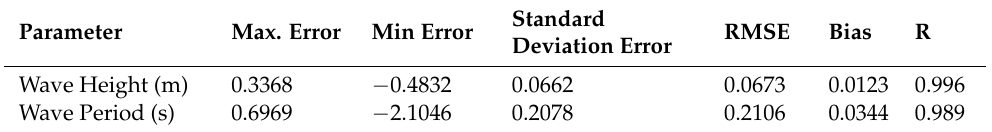
Table 7. The statistics of the ANN models for training results.